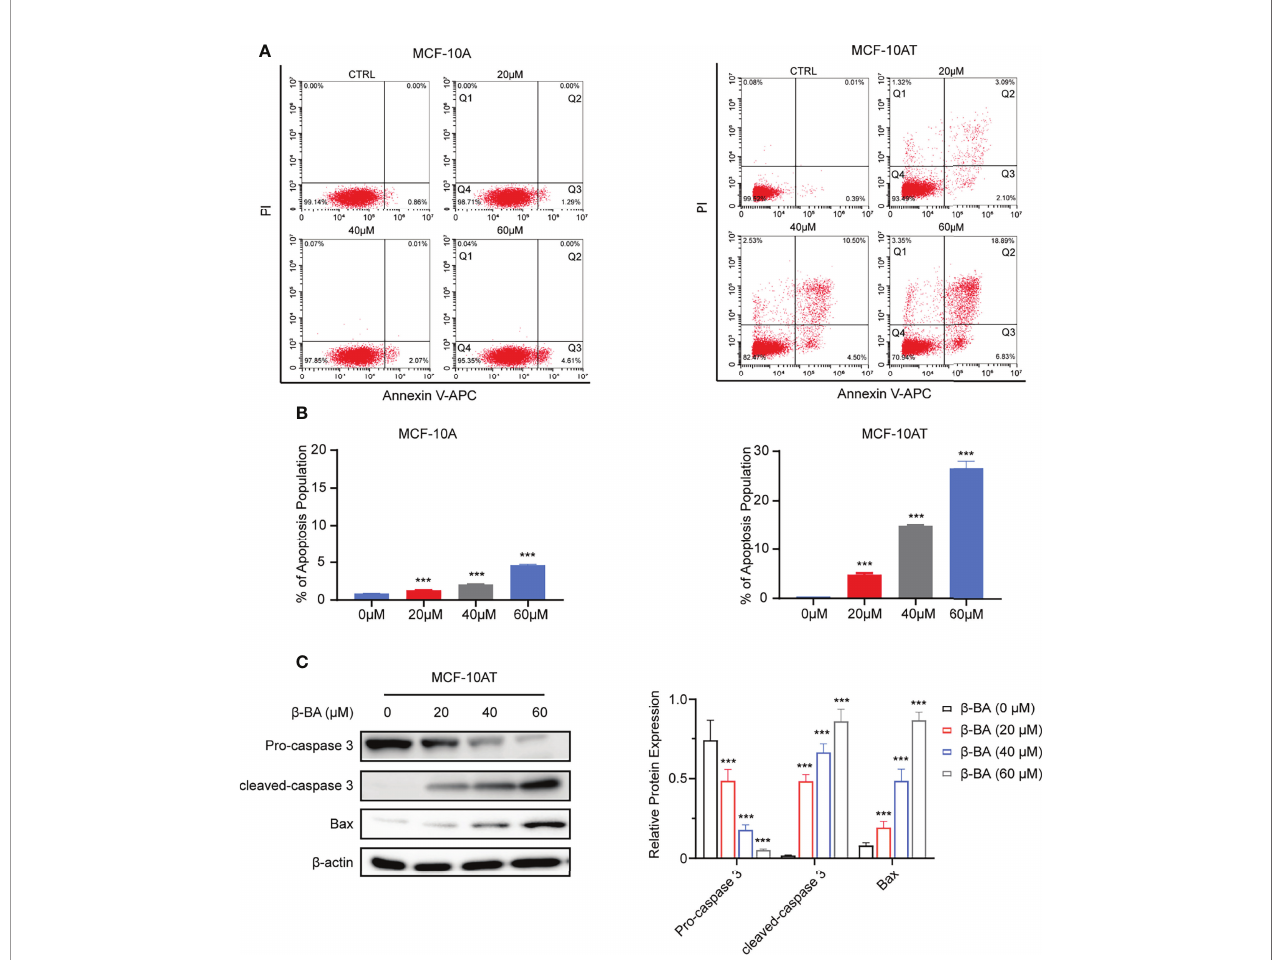
FIGURE 2 | b -BA promotes apoptosis in MCF-10AT. (A) FACS analysis Annexin V/PI staining was used to determine apoptosis induced by b -BA. (B) The population of early apoptosis and that of late apoptosis were counted. (C) The expression levels of cleaved-caspase 3, pro-caspase 3, and Bax were analyzed in MCF-10AT following a 48-h treatment with b -BA at designated concentrations. Protein levels were quanti fi ed by Image J and normalized with that of b -actin in the right panel. Data were shown as the mean ± S.D from independent experiments. *** p <